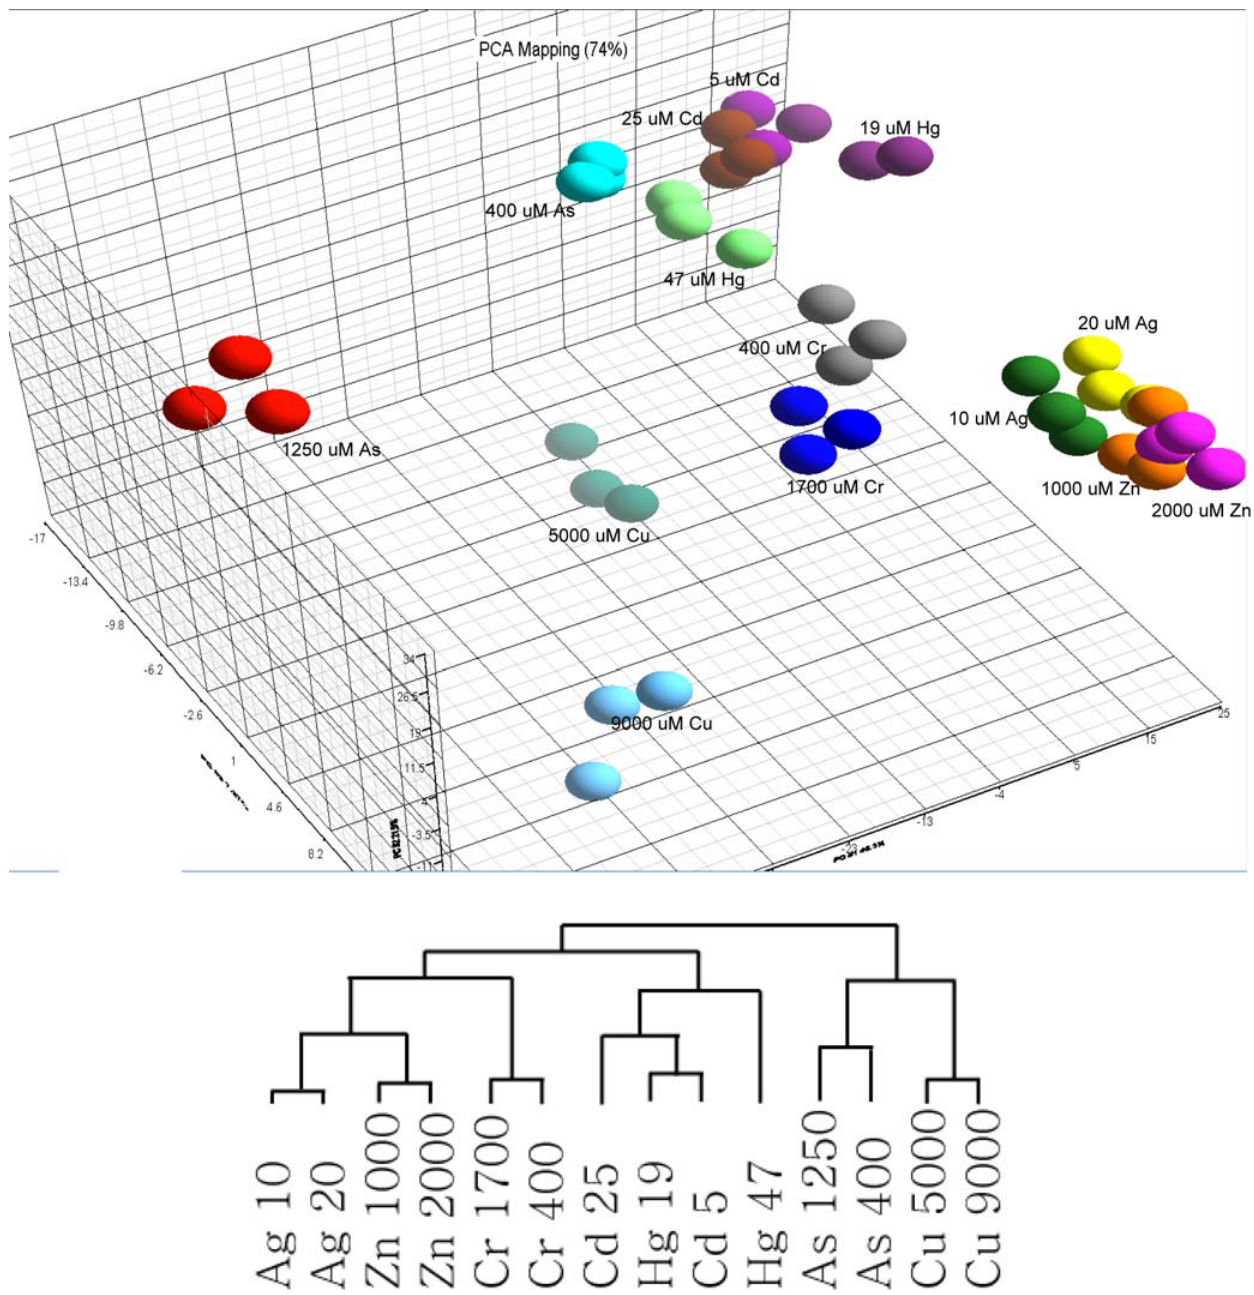
Figure 1. Principal Component and hierarchical cluster analyses. The fold-change of 1,341 differentially expressed genes was used in these analyses. ( Upper Panel ) Principal Component Analyses of three pairs of independent biological replicates with the same treatments are designated with identical colors. ( Lower Panel ) Hierarchical cluster by treatment of the gene expression data. This hierarchical cluster was calculated using the unfiltered 87,304 gene-treatment expression dataset.